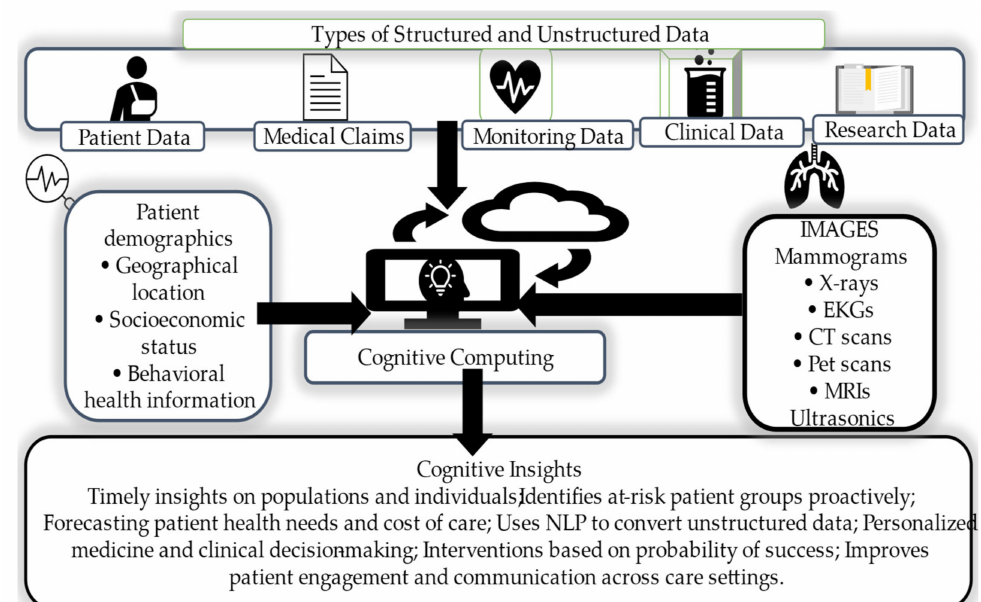
Figure 15. Cognitive computing for population health